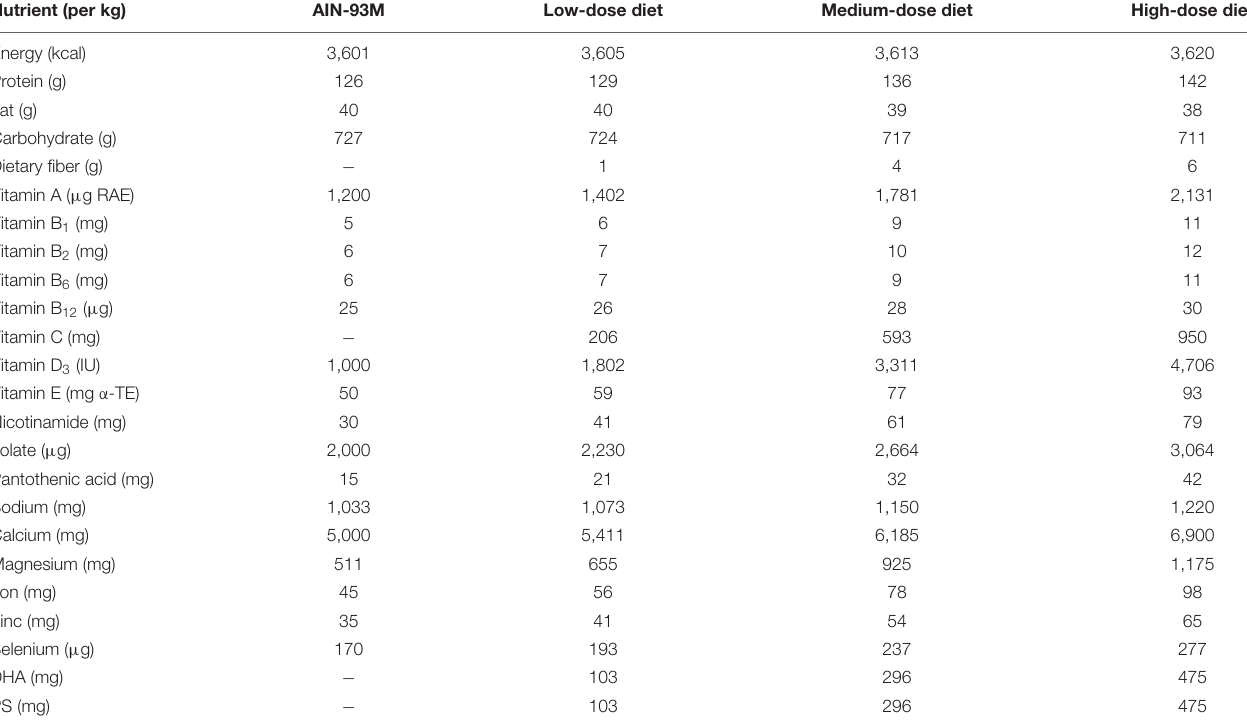
TABLE 2 | Components of the AIN-93M diet, and low-, medium-, and high-dose treatment diets (per kg). Nutrient (per kg) AIN-93M Low-dose diet Medium-dose diet High-dose